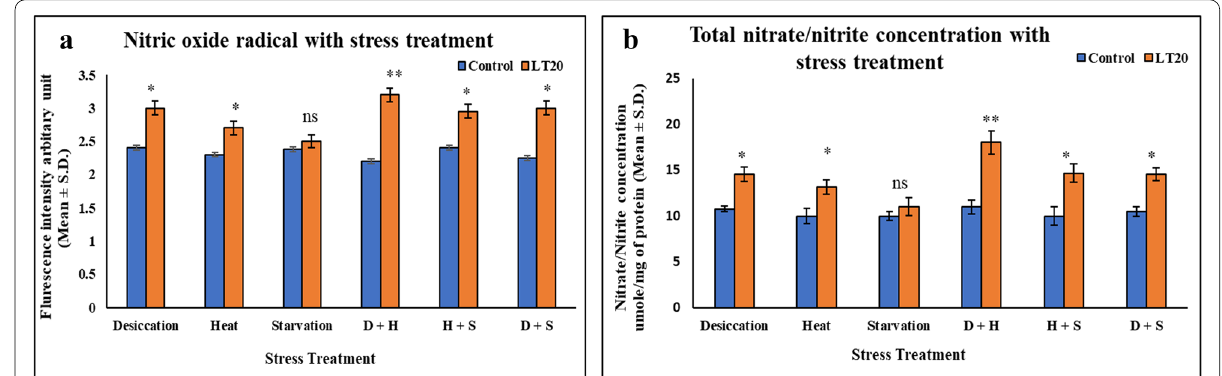
Fig. 4 Measurement of reactive nitrogen species (RNS) a Determination of Total Nitrate/Nitrite concentration μmole/mg of protein (mean fourth instar larvae of C. ramosus . b Estimation of level of nitric oxide radical arbitrary unit (mean represent mean and the vertical bars represent SD. Data shown are representative of three independent experiments. ***P < 0.001; **P < 0.01; *P < 0.05 indicates significance